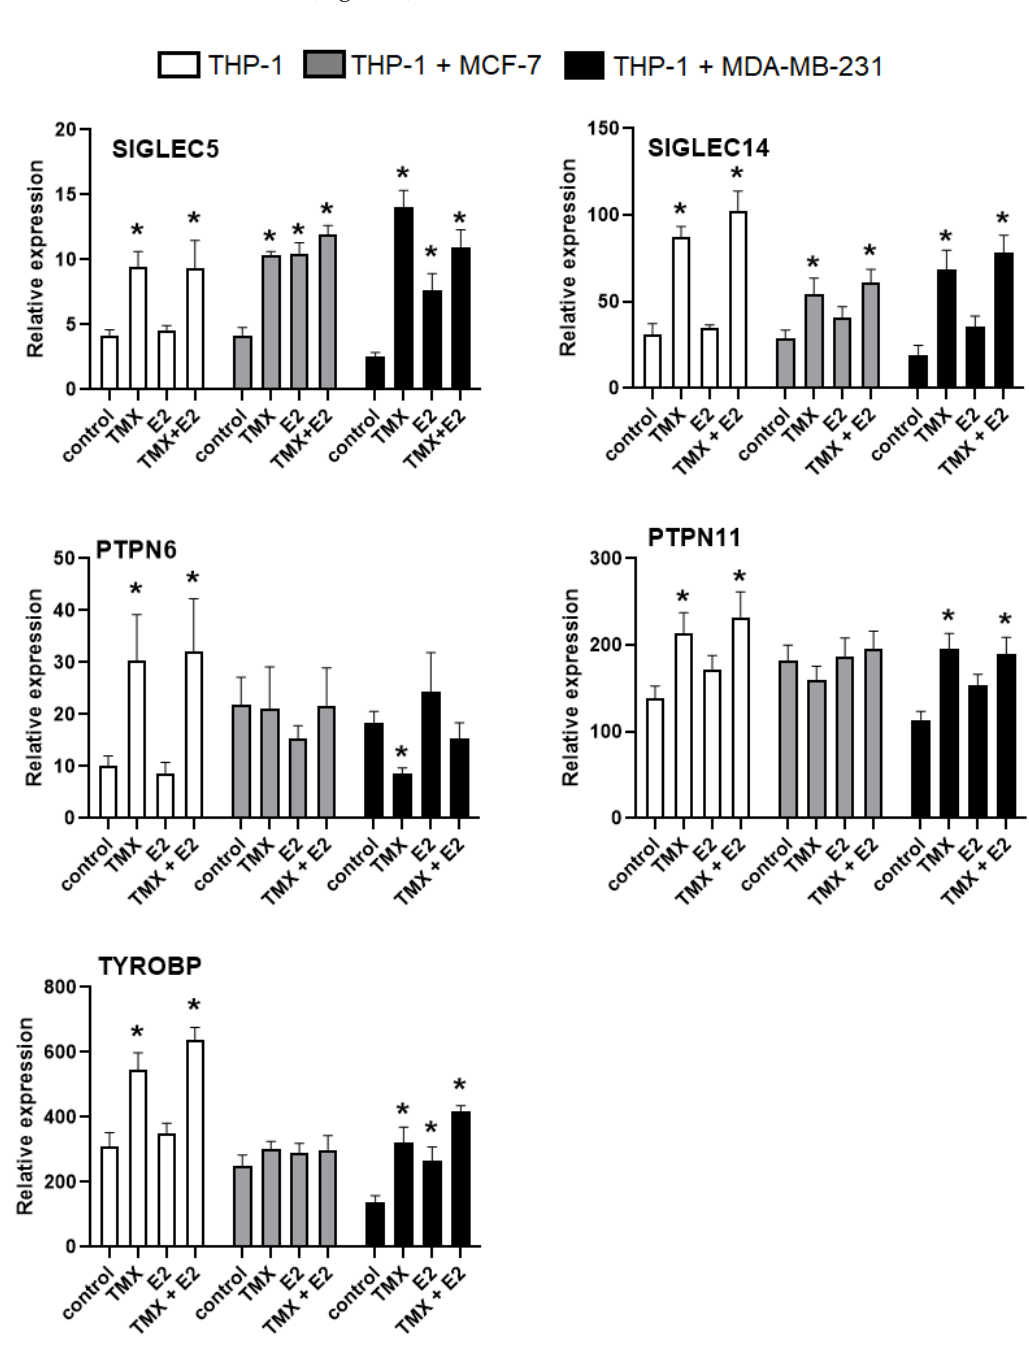
Figure 4. Expression of SIGLEC5 , SIGLEC14 , PTPN6 , PTPN11 and TYROBP mRNA in monocytes. The analysed transcripts were detected by real-time PCR in monocytic THP-1 cells grown in a monoculture and a co-culture. The housekeeping gene GAPDH was used as an internal loading control. Representative data show a mean of three samples. * p < 0.05 vs. the corresponding control